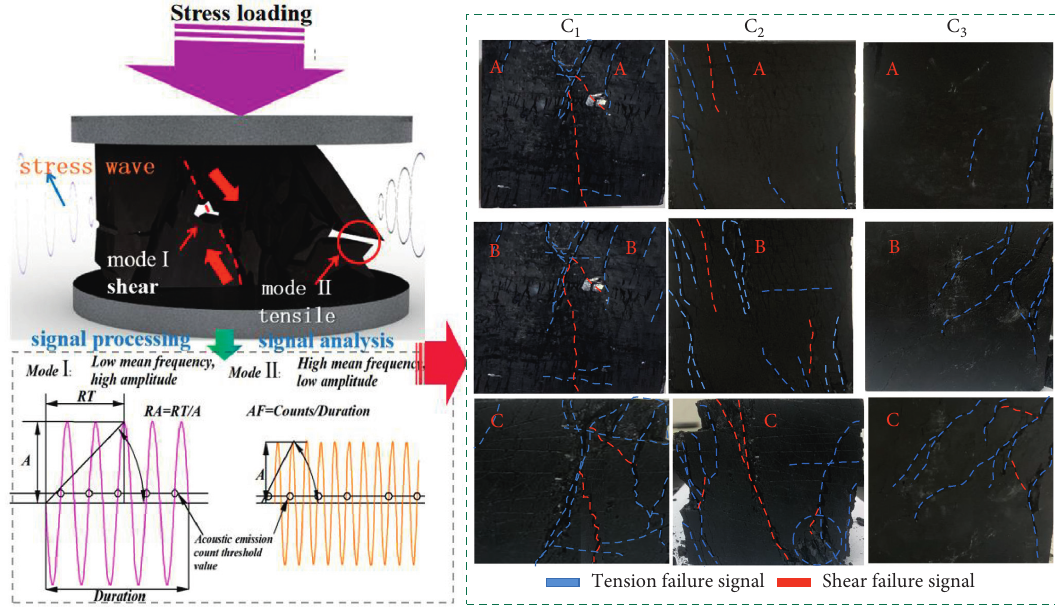
Figure 7: Coal mass fracture